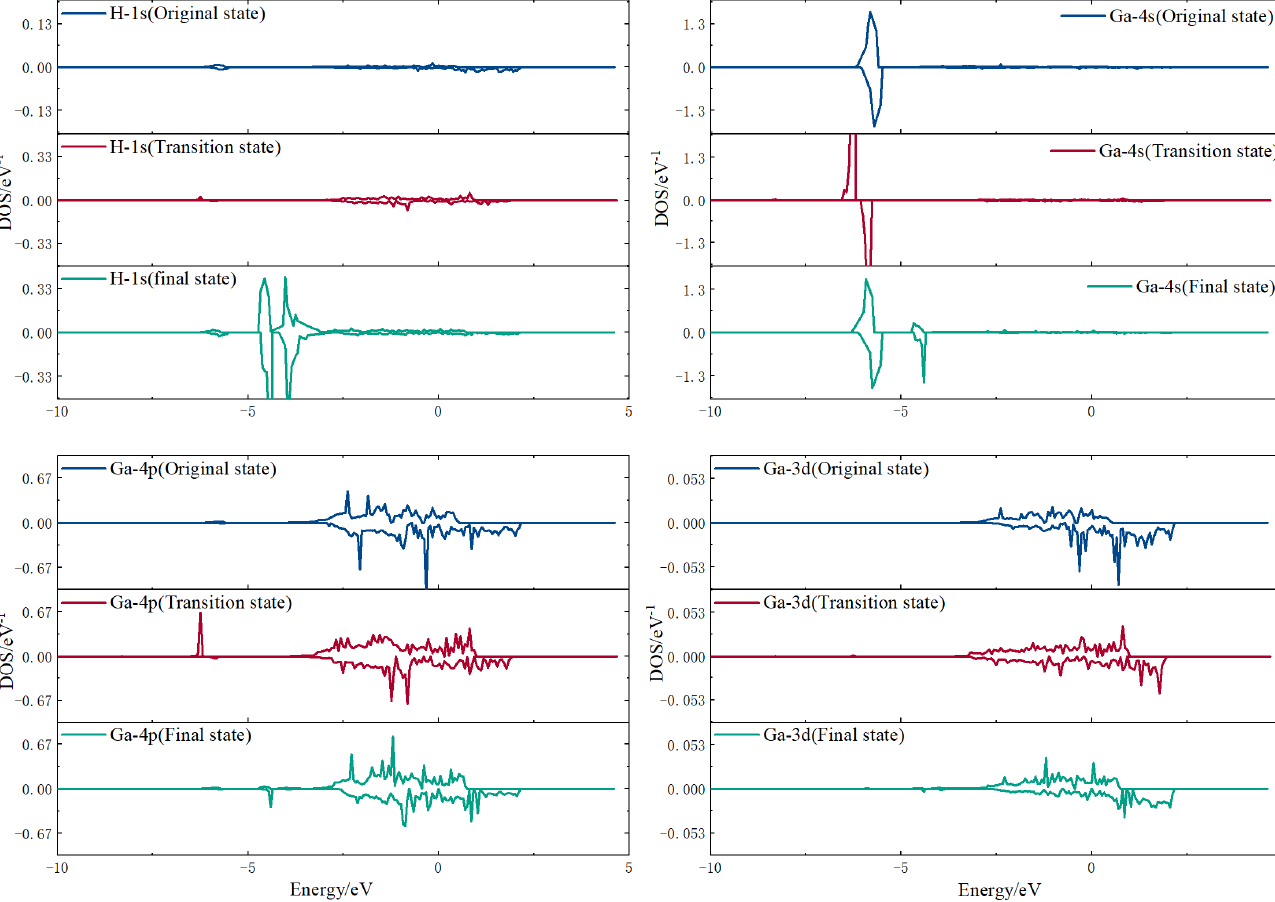
Figure 10. Variation of density of states of hydrogen and gallium atoms. For the hydrogen atom, the intensity of the initial state density peak is small, and the intensity of the peak increases in the transition state. Two significant spikes appear at − 4 eV in the 1s orbitals of the hydrogen atom at the end state, while the density of the electronic states near the Fermi energy level decreases compared to the transition state. For the gallium atom, its 4s orbital and 4p orbital both form a spike at − 4 eV, and its 3d orbital does not change much before and after, indicating that the H1s-Ga4s-Ga4p orbital hybridization between the hydrogen atom and the gallium atom creates a chemical bond with strong interaction. For the plutonium atom, its 6p and 5f electronic density of state does not change much, and there is only a weak peak at − 4 eV, while its 6s, 7s, and 6d orbitals produce an obvious sharp peak at − 4 eV. This indicates that the hydrogen and plutonium atoms are mainly hybridized by the H1s-Pu6s and 7s-Pu6d orbitals to form stable chemical bonds. Figure 12 show the fractional wave density of states after the dissociation of hydrogen molecules, which can visualize the orbital hybridization of hydrogen atoms with the surface. The 1s orbital of the hydrogen atom interacts with the 4s and 4p orbitals of the gallium atom to create a chemical bond. The 1s orbital of the hydrogen atom interacts with the 6s, 7s, and 6d orbitals of the plutonium atom to produce a chemical